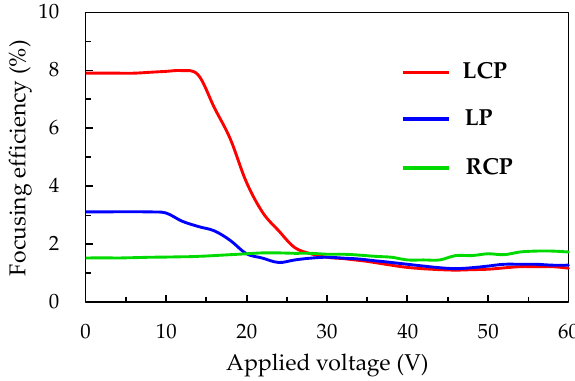
Figure 3. The variations of focusing efficiency of the Fresnel lens on the applied voltage probed with various polarized states of incident beams, left-handed circular polarization (LCP), linear polarization (LP), right-handed circular polarization (RCP).